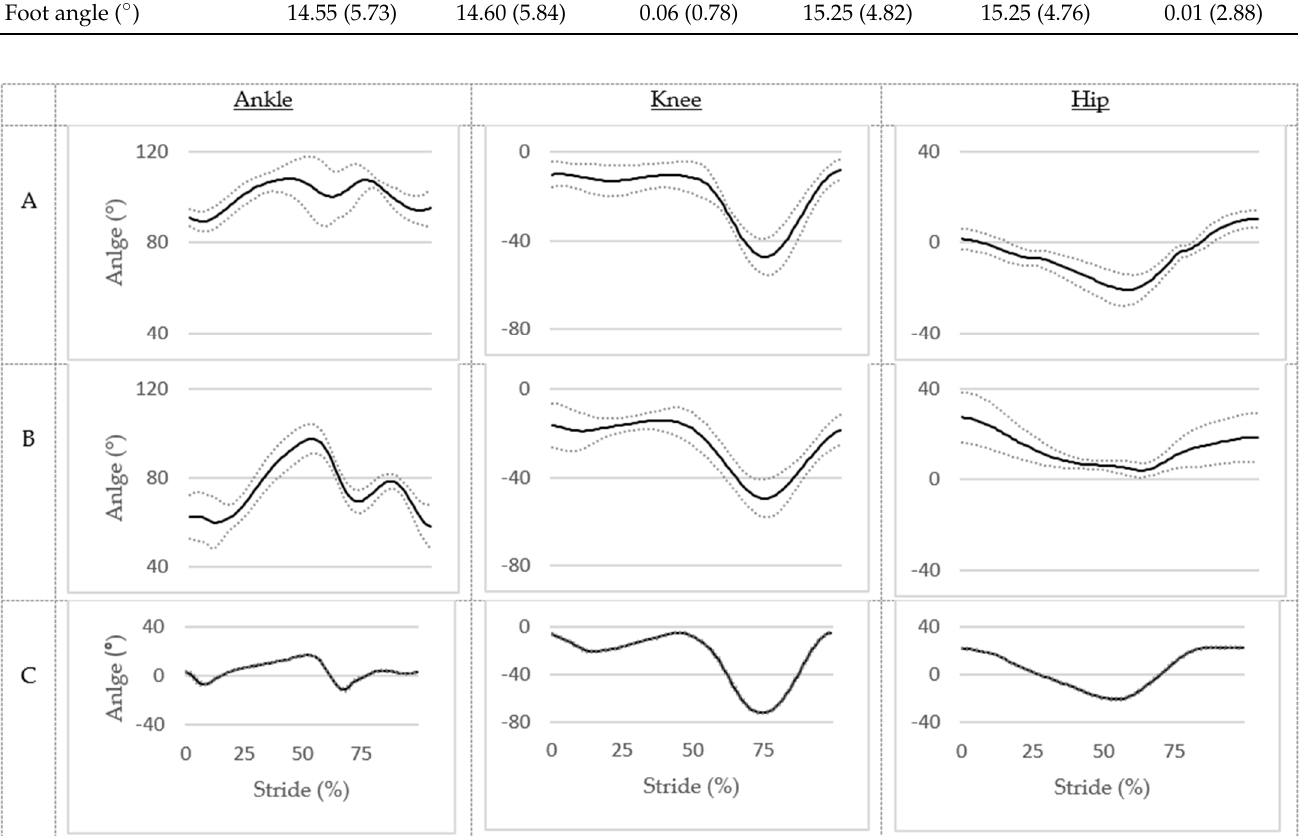
Figure A10. Ensemble averaged leg angles measured by the Smart Hallway towards the camera array (row ( A )) and away from the camera array (row ( B )). Comparator data [34] (row ( C )) show similar shape and range of motion. Grey dotted lines are the one-standard-deviation upper.